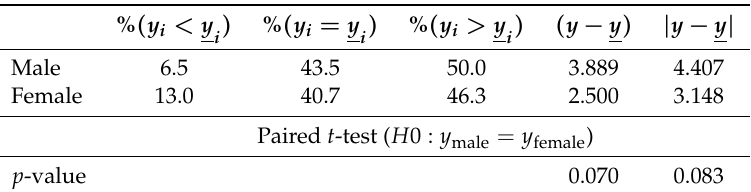
Table 3. Gender effect in internal